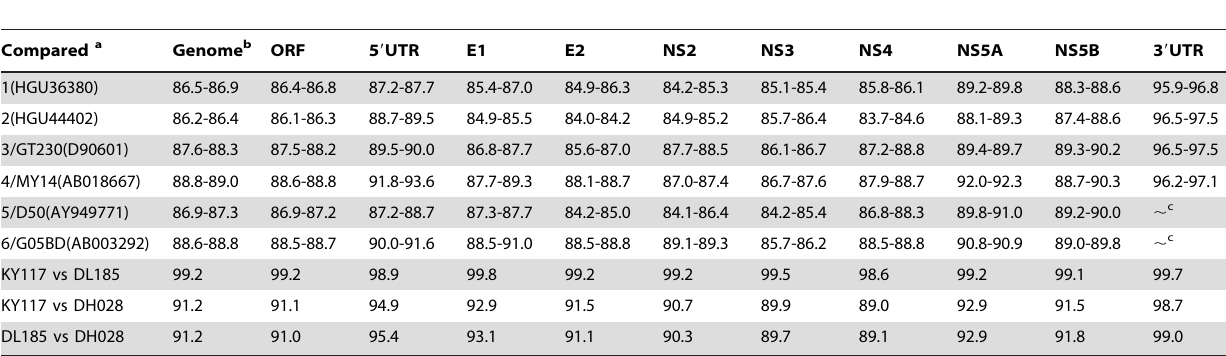
a Isolates to which the three genotype 7 sequences were pairwise compared. Each genotype was represented by one isolate as indicated with its Genbank accession number shown in parenthesis. b Over the entire genome length. c D50 and G05BD lack the 3’UTR.